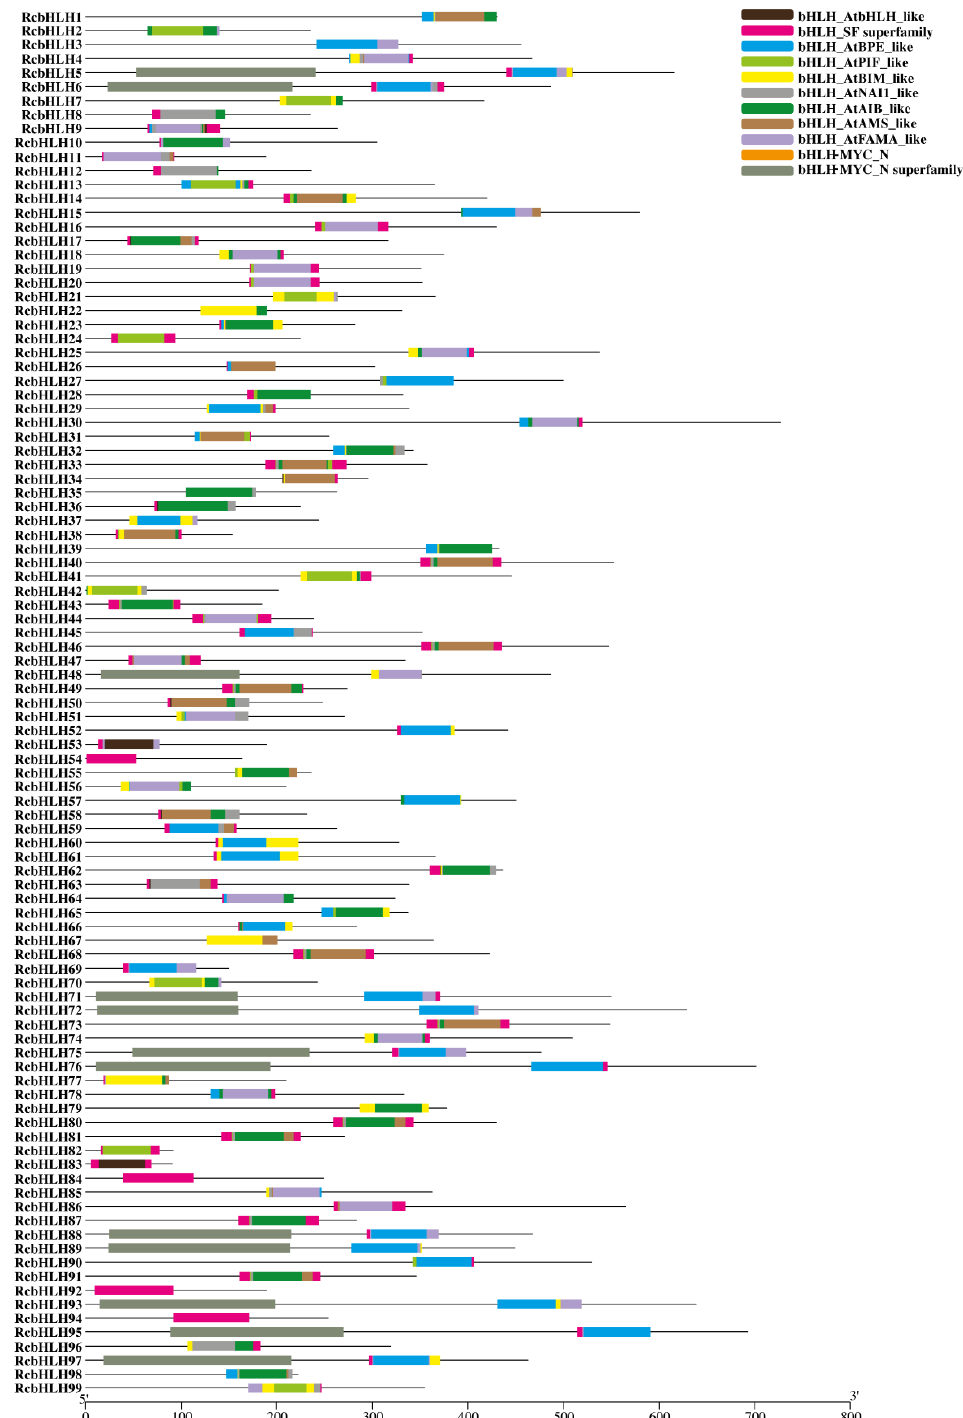
Figure 4. Domain analysis in RcbHLH gene members.